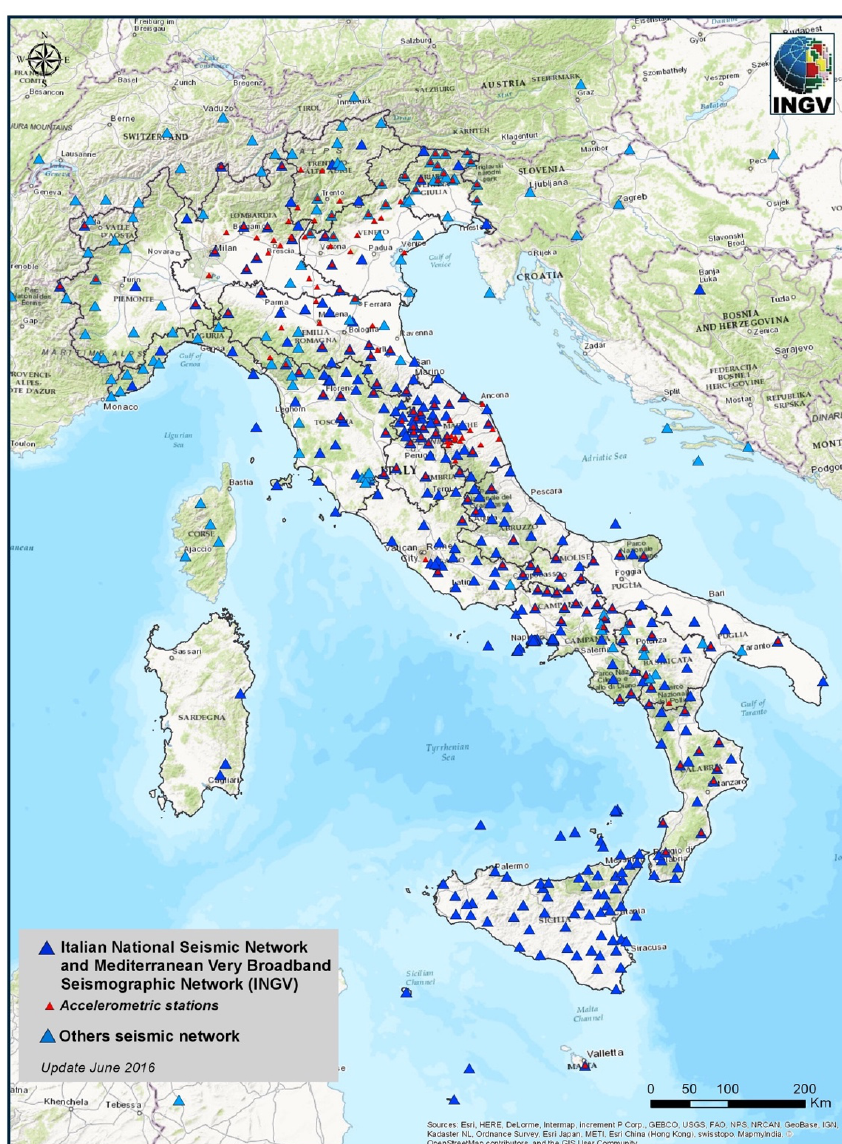
Figure 1. The Italian seismic network, RSN, dark blue triangles are the stations belonging to IV and MN networks directly owned and managed by INGV, light blue triangles are stations owned and managed by other national and international institutions that contribute to the INGV surveillance system. Red small triangles indicate stations equipped with